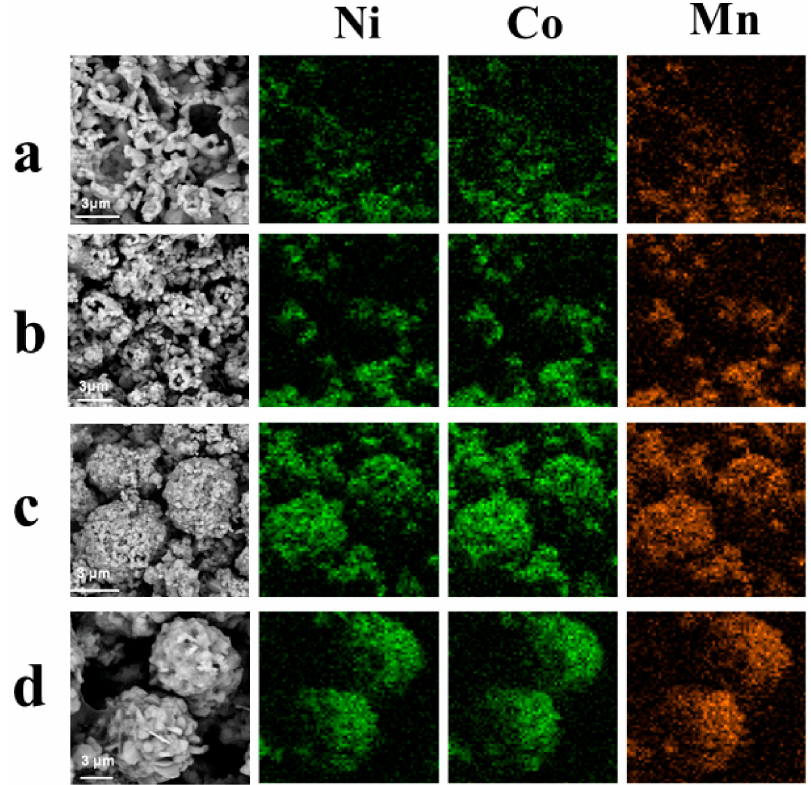
Figure 2. Energy-dispersive X-ray spectroscopy (EDX) patterns for distribution of Ni, Co, Mn on the surface of materials: ( a ) LNCM-0, ( b ) LNCM-1, ( c ) LNCM-2, ( d )